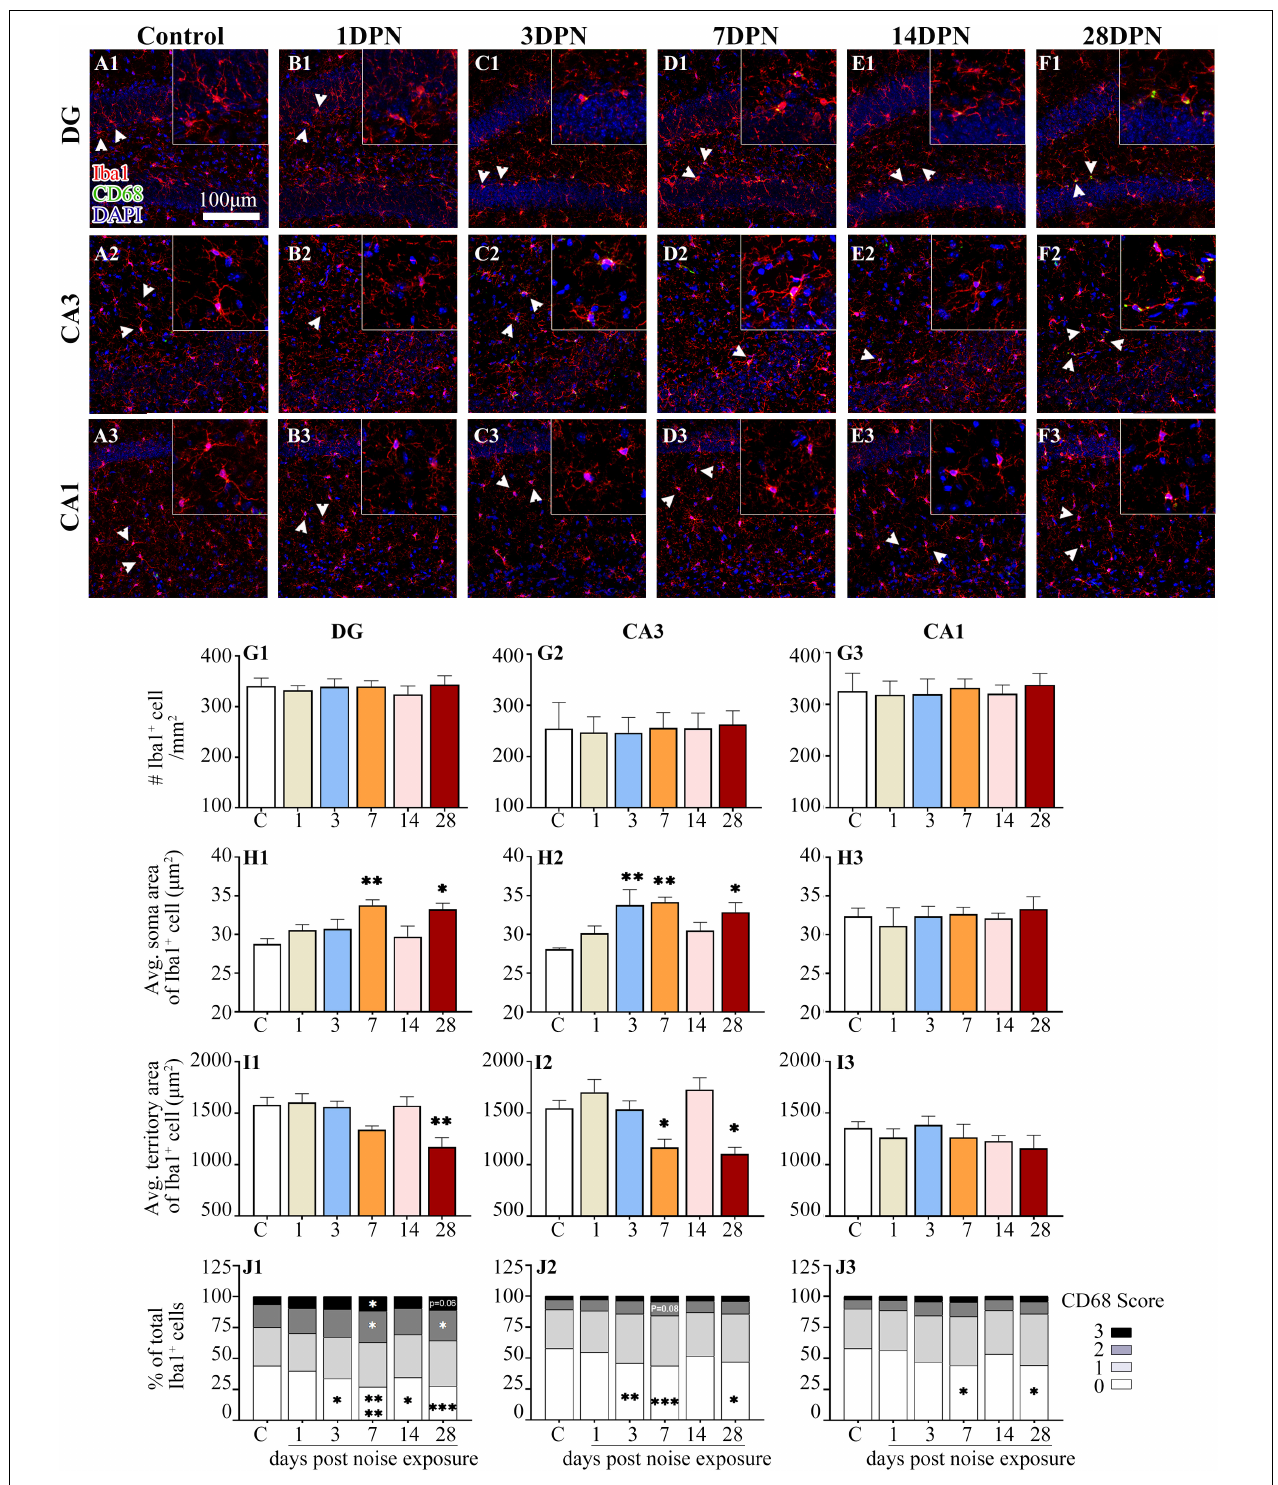
FIGURE 5 | Noise-exposed mice exhibited dynamic microglial alterations in the hippocampus. (A1–F3) Representative images of Iba1 (red)-, CD68 (green)-, and DAPI (blue)-stained brain sections of control and noise-exposed mice. Scale bar: 100 µ m. The insets show higher magnifications of the corresponding microglia signified by arrowheads. (G1–J3) Quantification of the impact of NE on each individual parameter of microglia in the DG, CA3, and CA1. The values are presented as the mean ± SEM of 3–6 mice per group. ∗ p < 0.05, ∗∗ p < 0.01, ∗∗∗ p < 0.001, ∗∗∗∗ p < 0.0001 in post hoc comparisons between the noise-exposed group and the control group following one-way